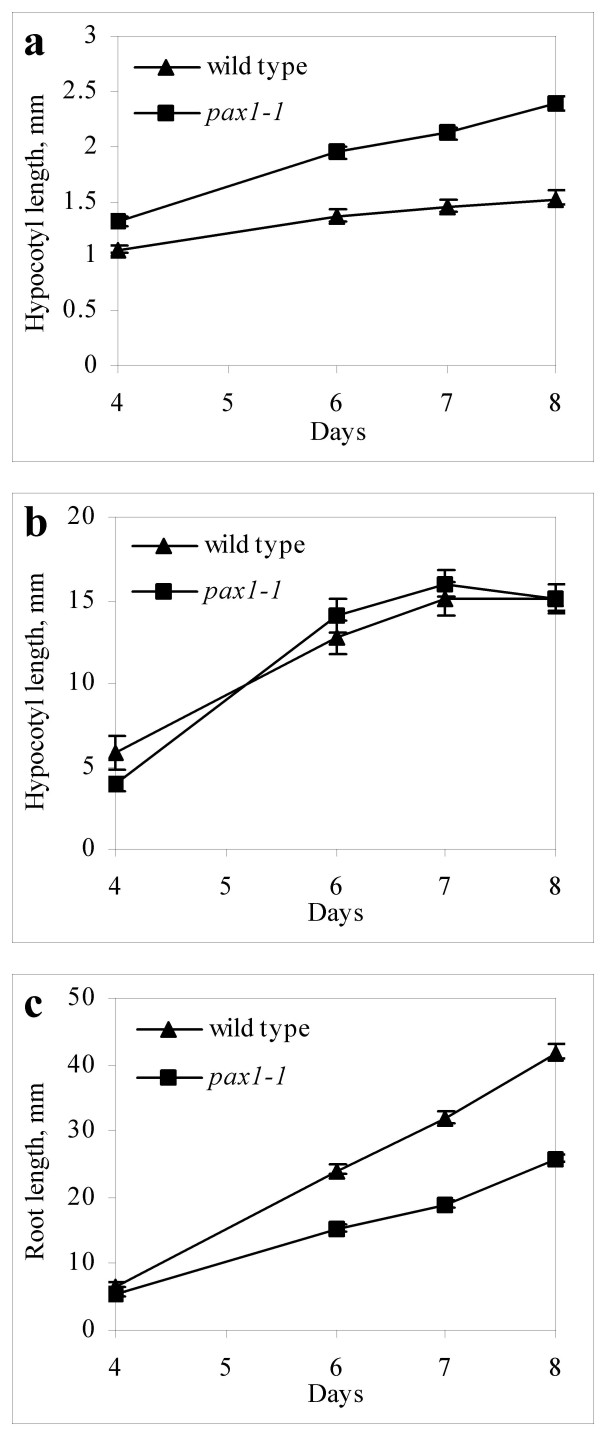
pax1-1seedling growth rates. (a) Hypocotyl elongation in light grown seedlings. n ≥ 15. (b) Hypocotyl elongation in etiolated seedlings. n ≥ 9. (c) Root elongation in light grown plants. n ≥ 19. Measurements were taken at various times after sowing. Error bars represent standard errors of the means (SE).